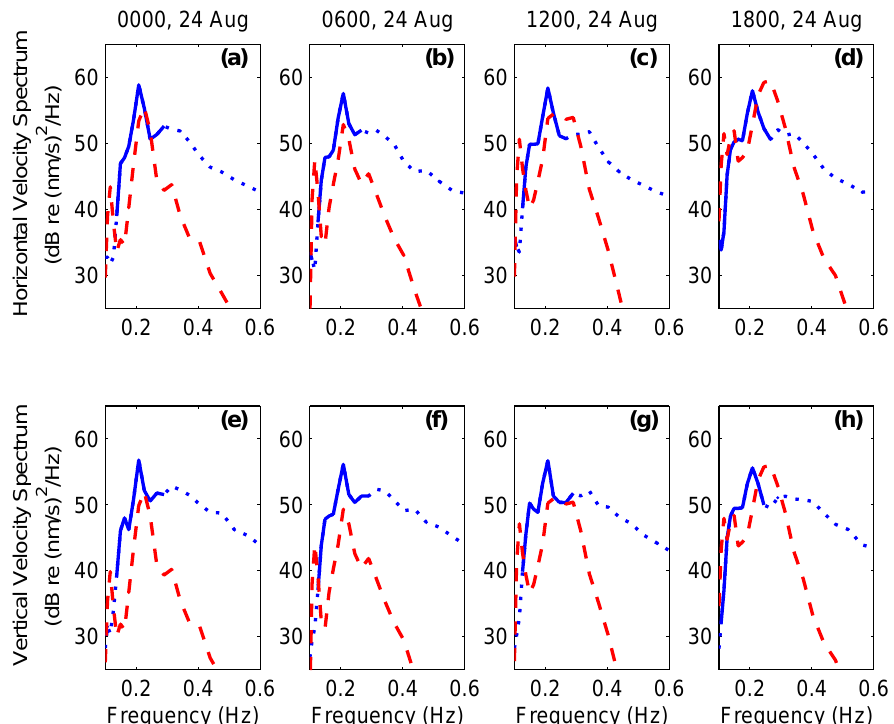
Figure 5. Horizontal ( a – d ) and vertical ( e – h ) velocity spectra modeled (red dashed) and measured (blue) at the seismometer in Florida at four times on 24 August 1998. The dotted blue lines represent portions of the data that where dominated by non-hurricane related ambient noise. Note that the peak in the spectra is at roughly f = 0.2 Hz. This frequency corresponds to the peak in the wave height spectrum at κ = 0.04 rad/m seen in Figure